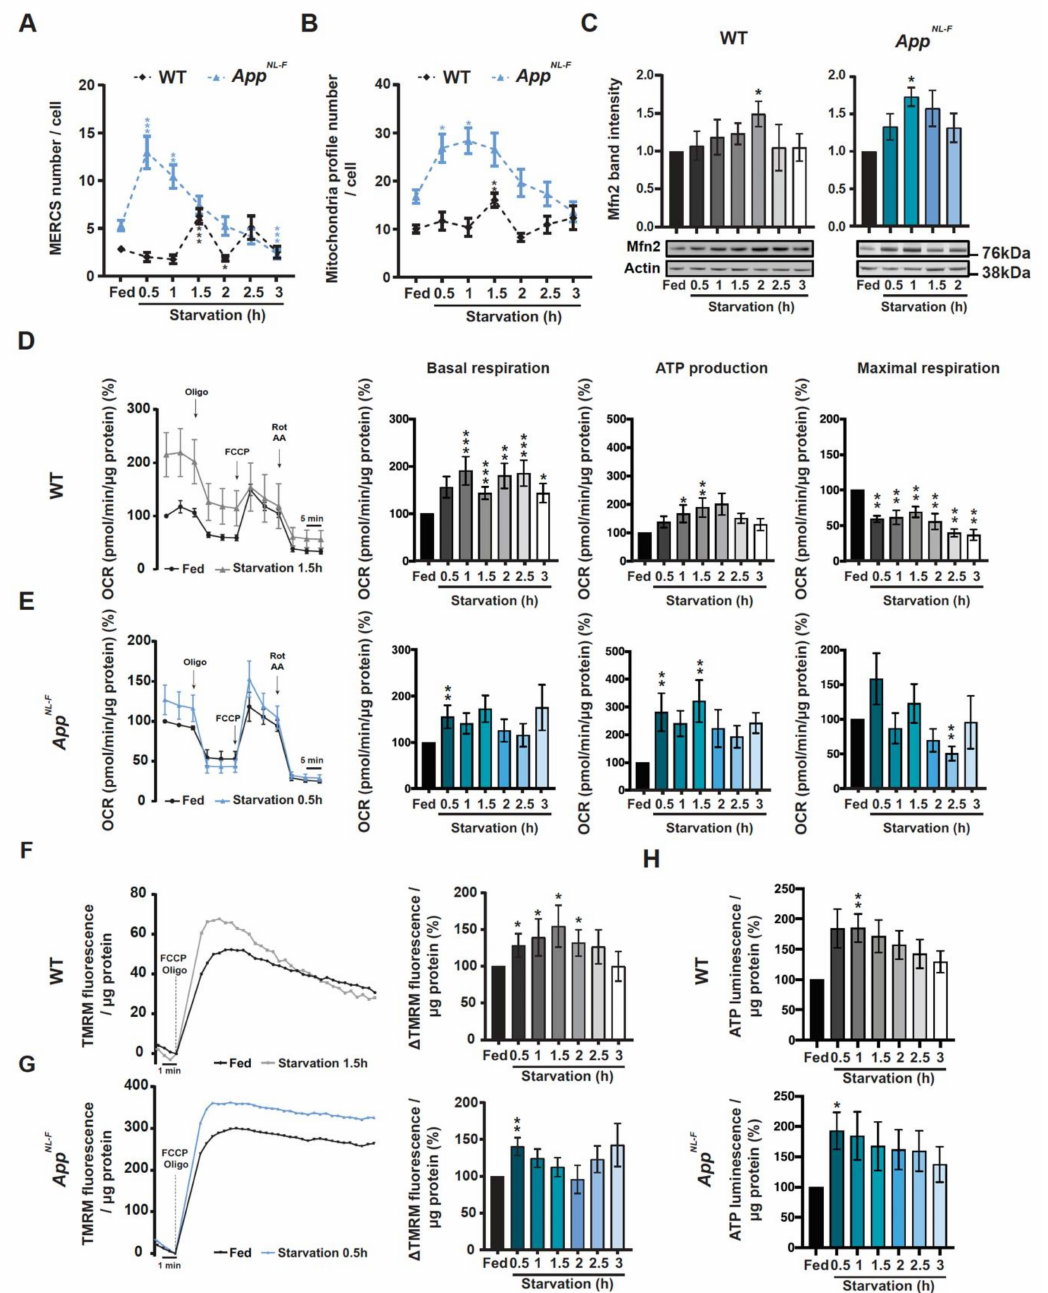
Figure 4. MERCS and mitochondria ultrastructure as well mitochondrial respiration, membrane potential and adenosine triphosphate (ATP) formation are altered during starvation in a